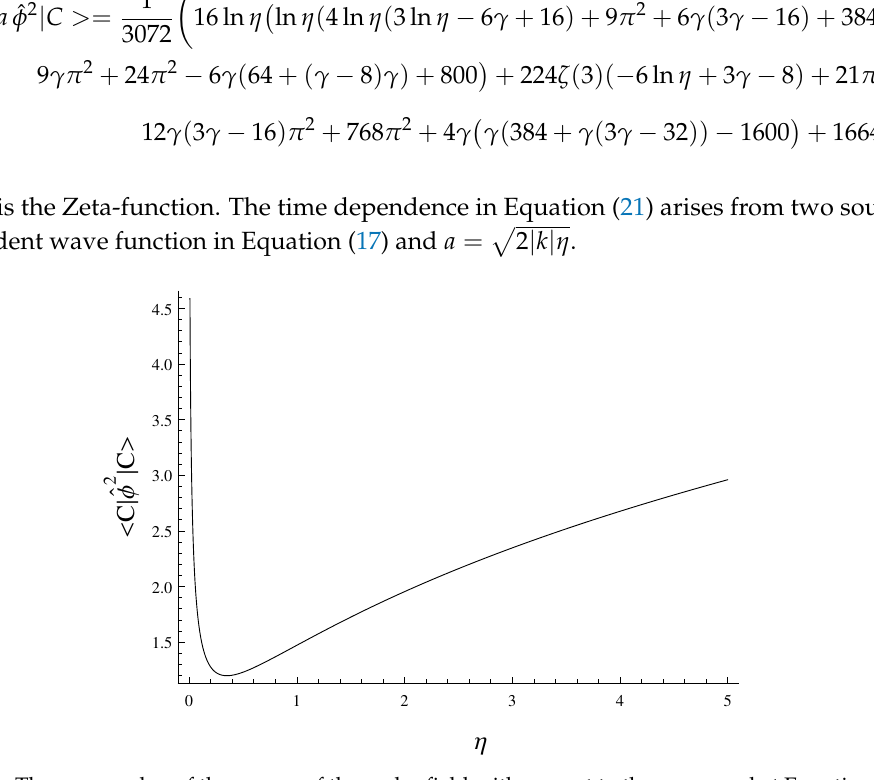
Figure 1. The mean value of the square of the scalar field with respect to the wave packet Equation